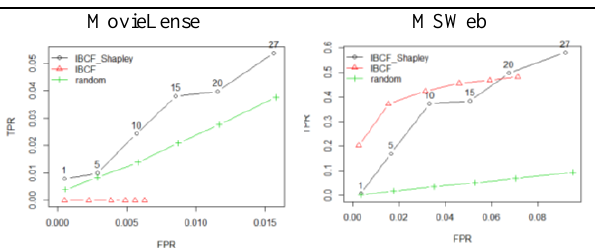
Figure 1. ROC curve of three models on MovieLense and